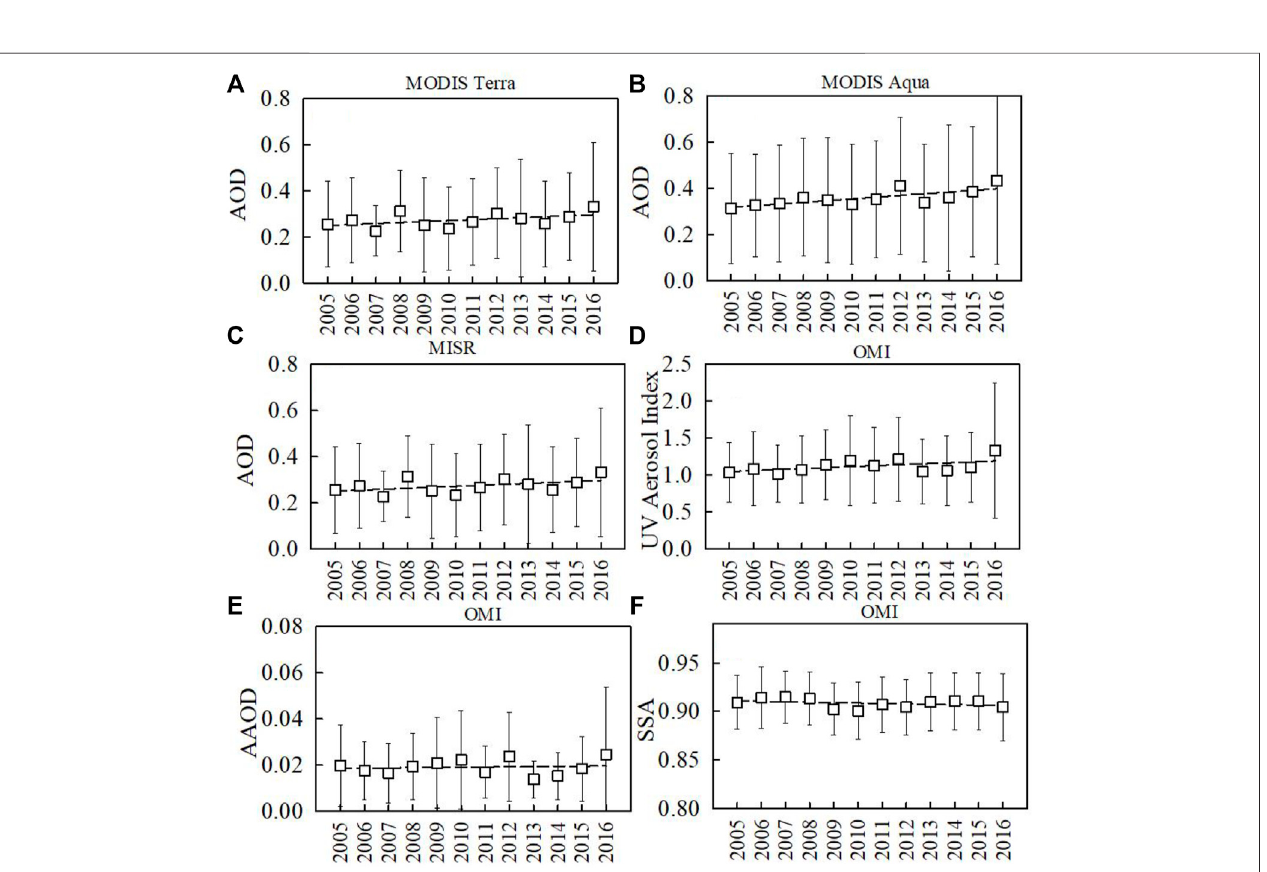
FIGURE 7| Regional picture of aerosol trends over a 1× 1 ° grid region, including both the Himalayan site and its adjacent foothill regions for theyears 2004 – 2016. TrendinAODobtainedfrom (A) MODISterraat550 nm, (B) MODISAquaat550 nm,and (C) MISRat555 nm.Trendsin (D) UVAerosolIndex, (E) AAODat500 nm,and (F) Single Scattering Albedo (SSA) at 388 nm obtained from OMI data are also shown.